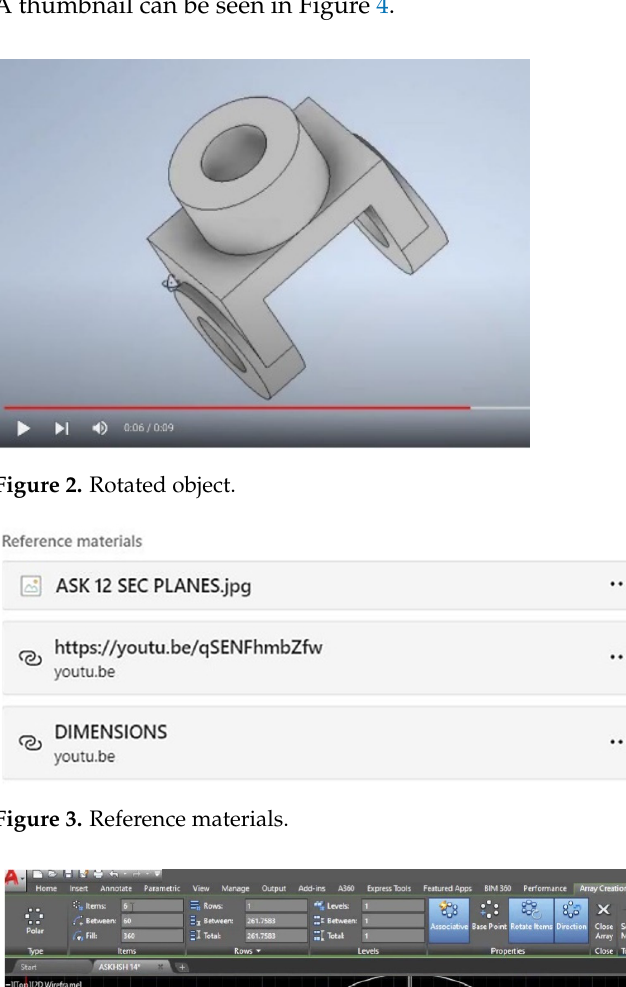
Figure 1. Scheme of the tasks’ assignment procedure.